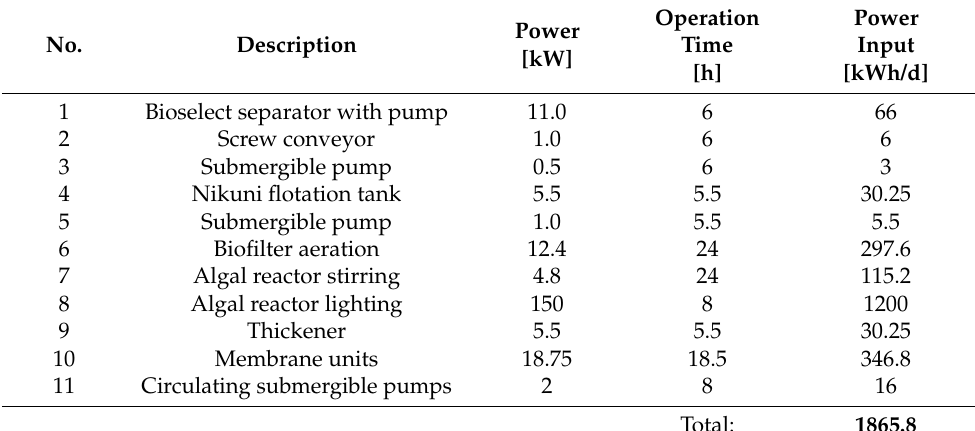
Table 4. Energy is required to power the system for producing algal biomass and treating